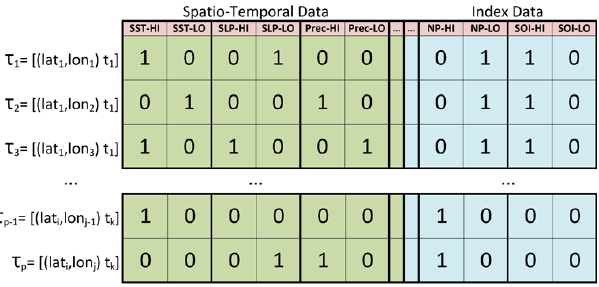
Figure 3. Climate indices can be distant, or many times partially co-located, complicating spatial alignment.